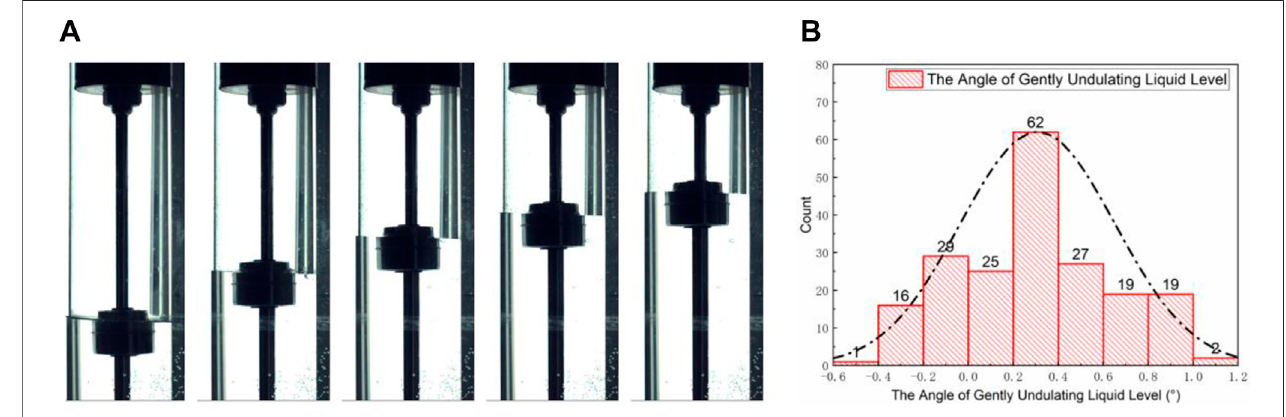
FIGURE 7 | In fl uence analysis of liquid level fl